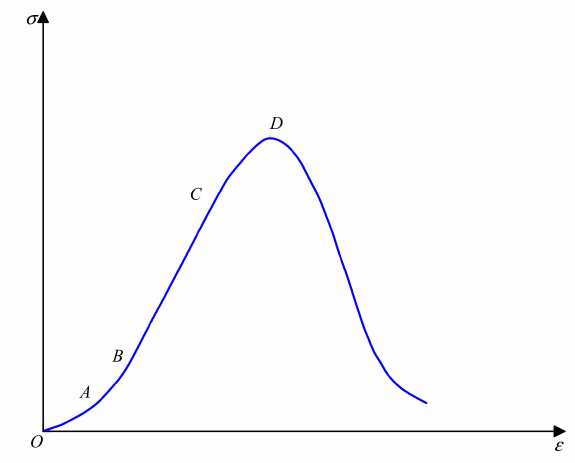
Figure 2. Total stress-strain curve of rock